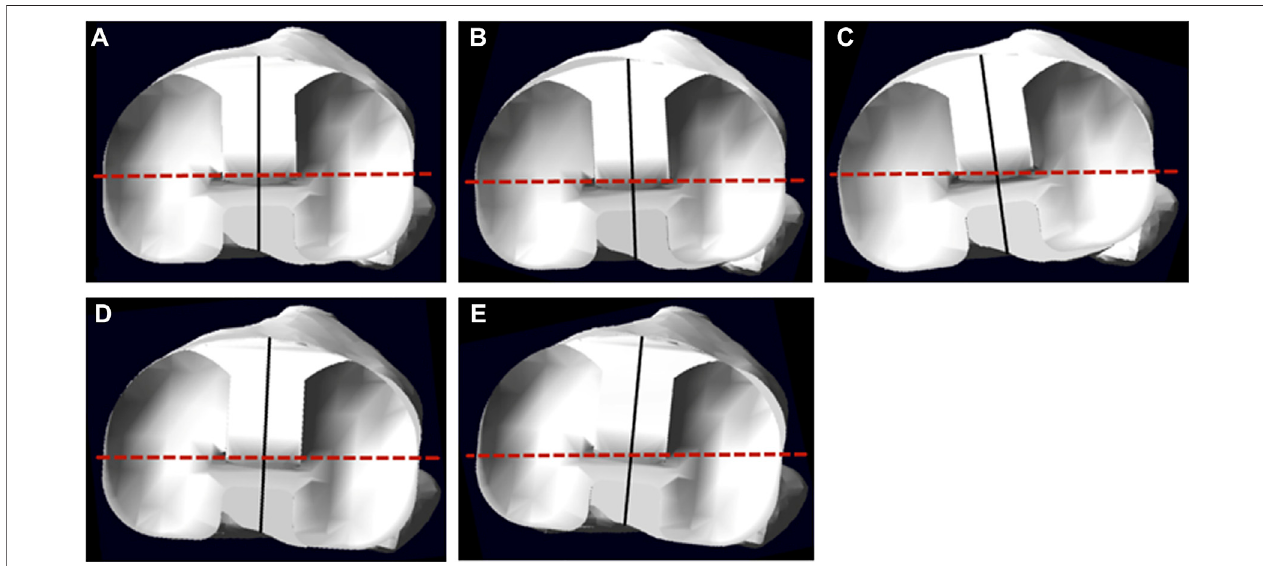
FIGURE 1 | The superior view of the tibial component on the tibia; the solid line indicates the anterior – posterior axis of the tibial component, and the dotted line indicates the projection of the TEA. (A – E) show models A, B, C, D, and E, respectively.